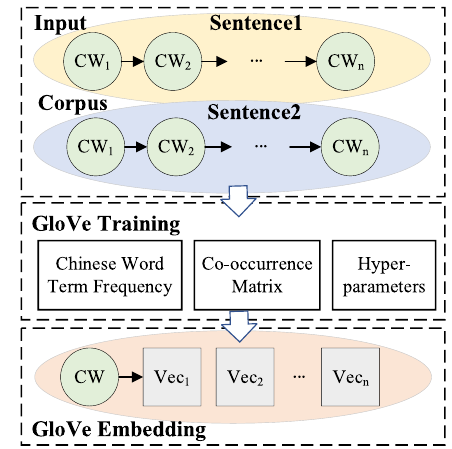
Fig. 2 The flow of TF-IDF N-gram embedding